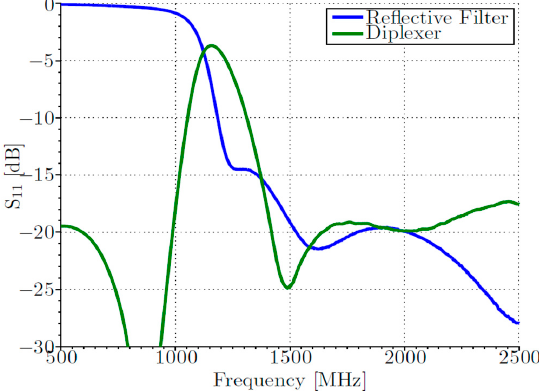
Figure 5. S-parameters of the Mini-Circuits VHF-1200 high-pass filter and RBF-272 diplexer in the high pass configuration.